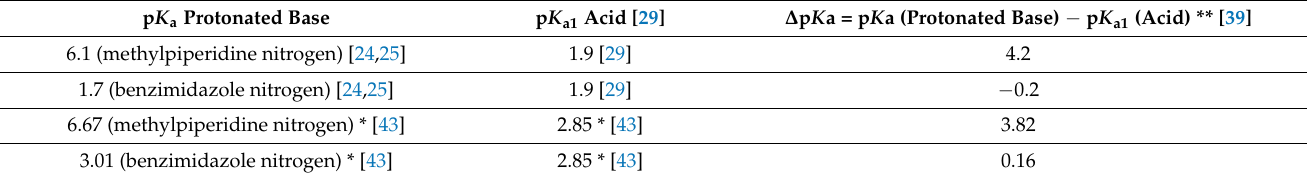
Table 4. Calculated ∆ p K a values for glasdegib–maleic acid complex considering glasdegib methylpiperidine nitrogen/maleic acid pair and benzimidazole nitrogen/maleic acid pair. p K a Protonated Base